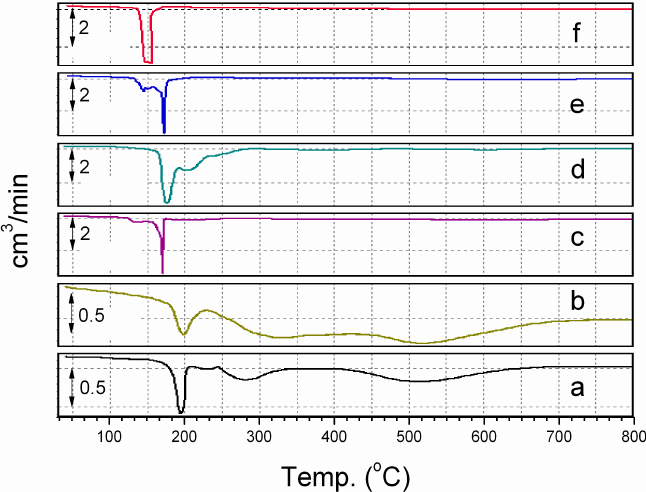
Figure 5. Temperature programmed reduction profiles for ( a ) physical mixture of Co(H 2 O) 6 .(NO 3 ) 2 + VXC, ( b ) 5 wt. % Co/VXC, ( c ) 5 wt. % Co + 1.25 wt. % Pd/VXC, ( d ) 5 wt. % Co + 2.5 wt. % Pd/VXC, ( e ) 5 wt. % Co + 5 wt. % Pd/VXC, and ( f ) 5 wt. % Pd/VXC.